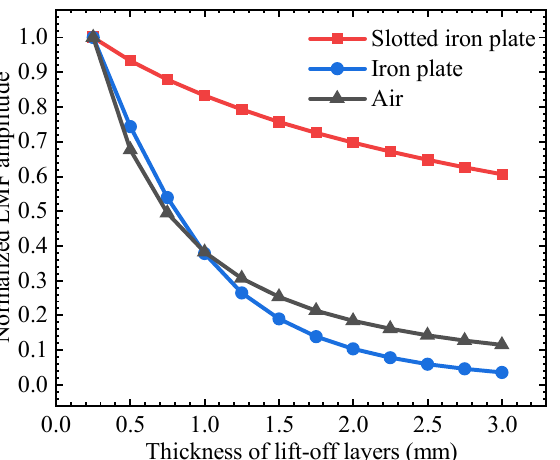
Figure 13. The relationship between the B x and the thickness of the lift-off layer for the slotted iron plate, iron plate, and air lift-off layer.